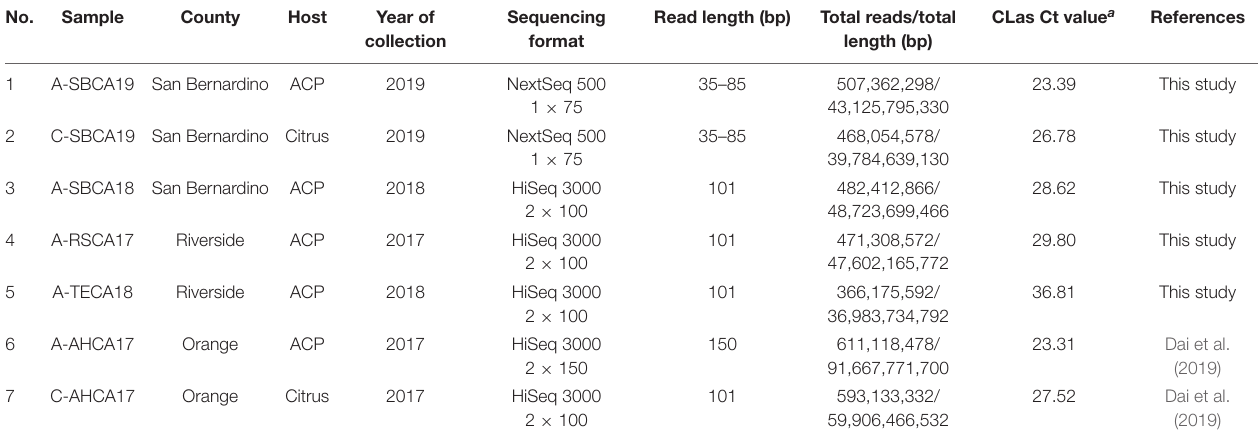
TABLE 1 | General information and selected metrics of next-generation sequencing data of Asian citrus psyllid (ACP) and citrus leaf DNA samples from southern California, United States.